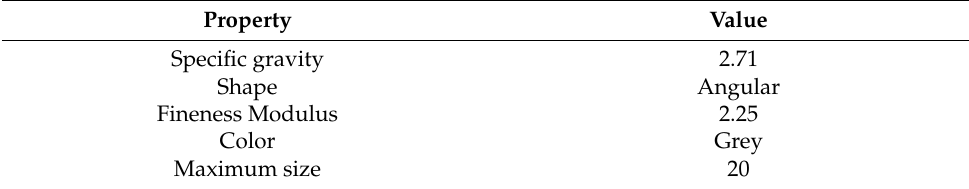
Table 2. Properties of coarse aggregates.